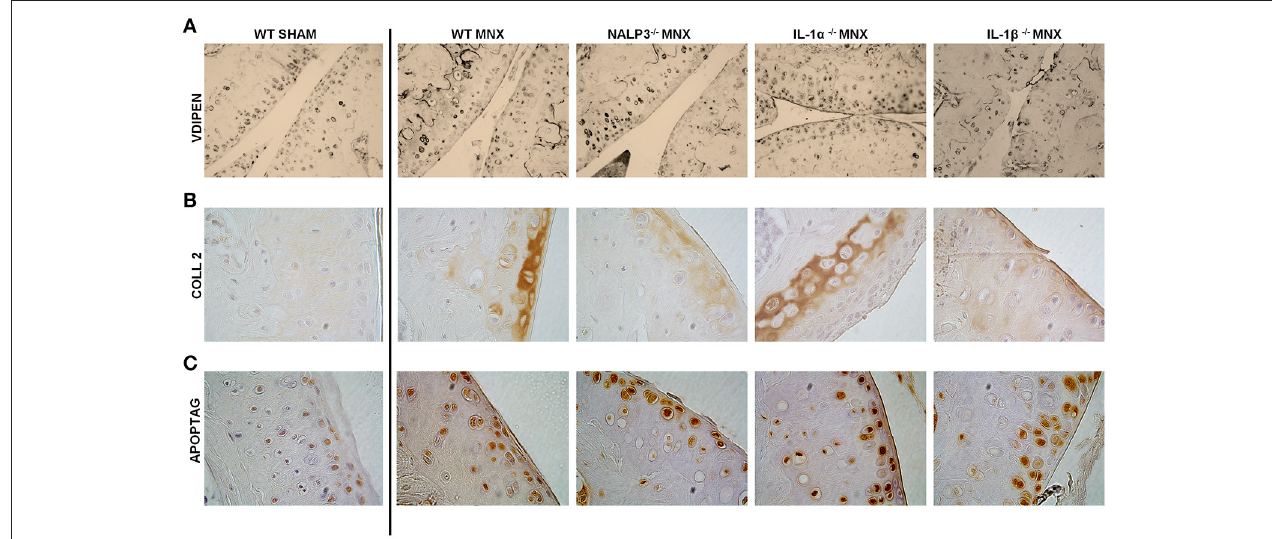
FIGURE 2 | Knock-out mice are not protected against catabolic changes and chondroptosis caused by OA induction. (A) Representative immunohistochemical sections of knee joints, stained for MMP-mediated proteoglycan degradation (VDIPEN staining). Note markedly increased VDIPEN in MNX knees if compared to sham-operated mice and no protection in knock-out mice. (B) Representative immunohistochemical sections of knee joints, stained with anti collagen type 2 antibody. Note increased collagen type 2 synthesis in the superficial and deep cartilage layers of MNX mice compared to the sham operated mice and the similar expression of collagen type 2 in WT and KO menisectomized knees. (C) Representative immunohistochemical sections of knee joints, stained with ApopTag. Note increased apoptosis in MNX mice compared to sham operated mice and the similar level of chondrocyte aptosis in WT and KO menisectomized knees. Mice